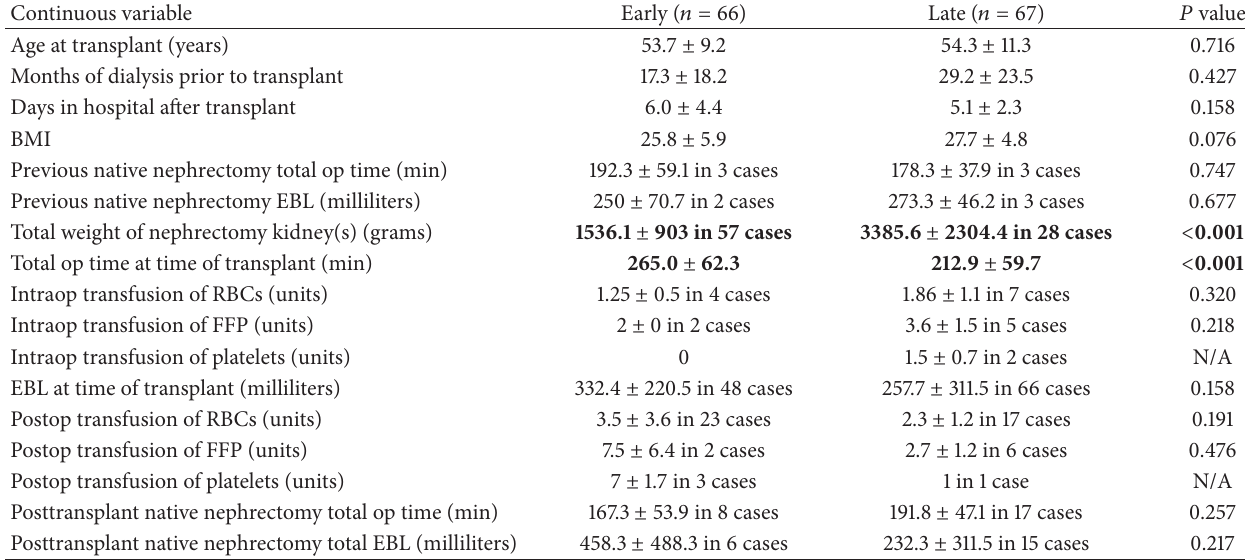
Table 3: Comparison of continuous variables among the early and late experience in patients receiving transplantation for adult polycystic kidney disease.